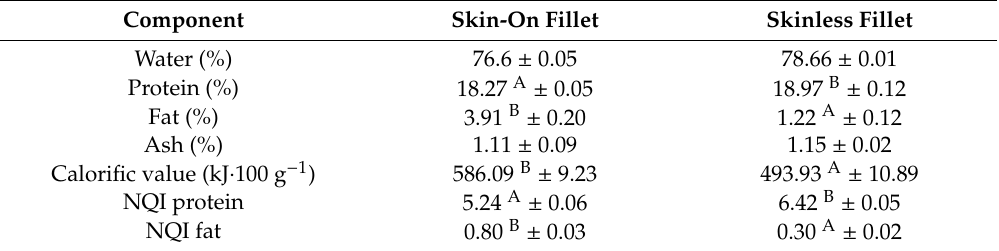
Table 1. Proximate composition, calorific value, and nutritional quality index (NQI) of the protein and fat of Prussian Carp ( Carassius gibelio ) fillets (mean ± SD).